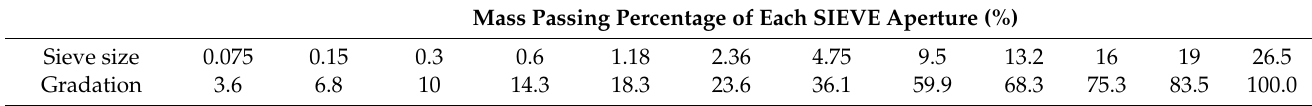
Table 3. Test gradation of cement-stabilized